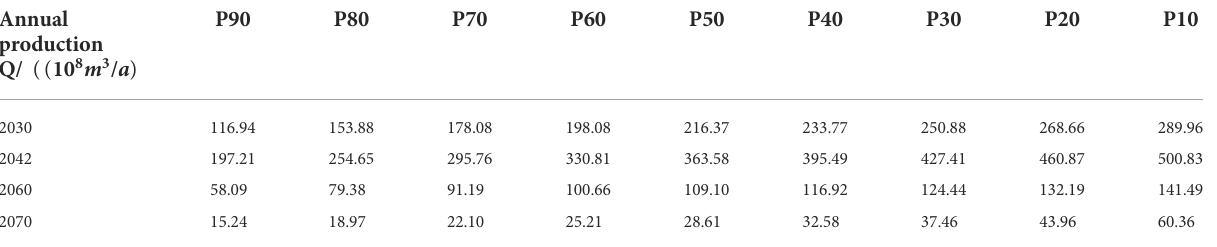
TABLE 3 Production realization probability calculation results of different stage